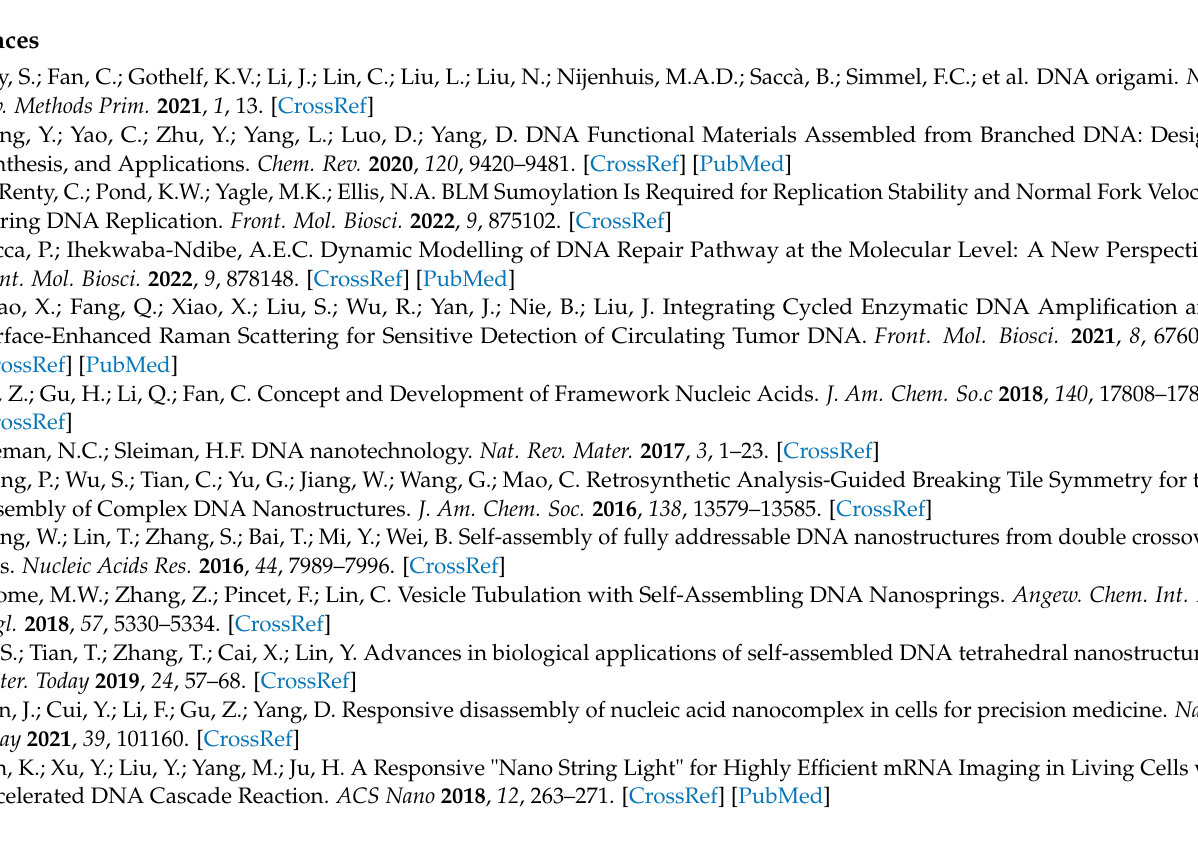
motifs; Figure S2: Enlarged view of Figure 2c in the main text and an additional AFM image of DNA nanoladders; Figure S3: Steps for measuring ladder length in FIJI; Figure S4: Dimensional measurement of pores; Figure S5: Additional AFM images of DNA nanoladders at different incubation times; Figure S6: Counting process of nanoladder pores; Figure S7: Additional AFM images of DNA nanoladders at different incubation temperatures; Figure S8: AFM images of nanostructures incubated at 40 ◦ C and 45 ◦ C; Figure S9: Additional AFM images of DNA nanoladders at different ratios; Table S1: The DNA sequences used to assemble DNA